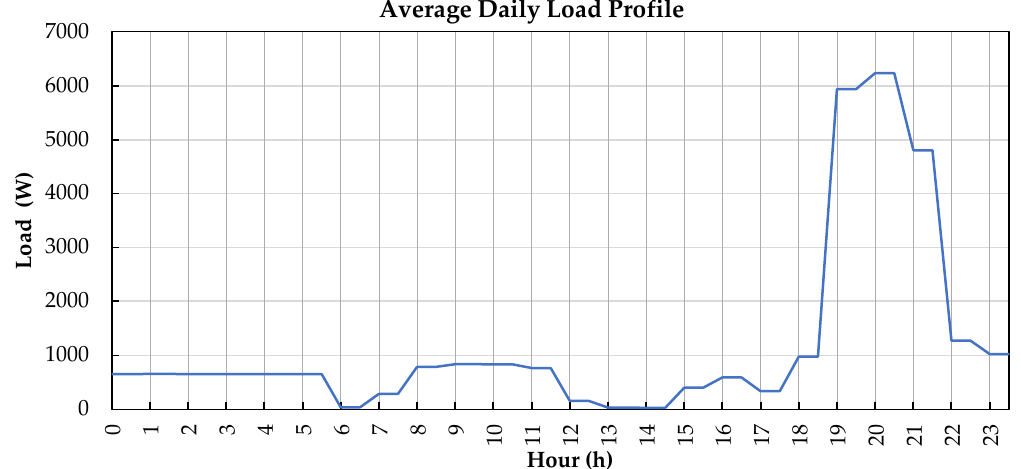
Figure 4. Average daily load profile, Tacuaral de Mattos, Bolivia.